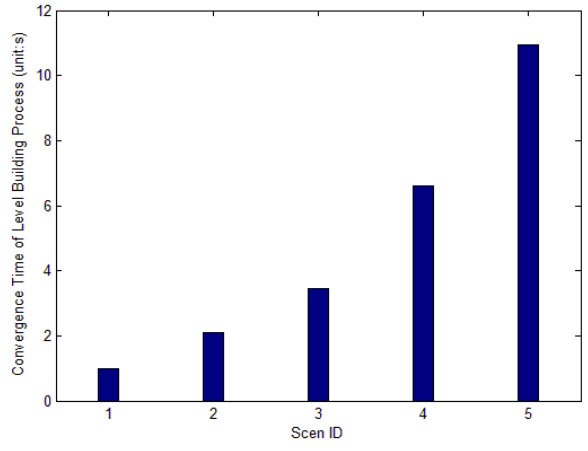
Figure 16. Convergence rate of level building process in each scenario.